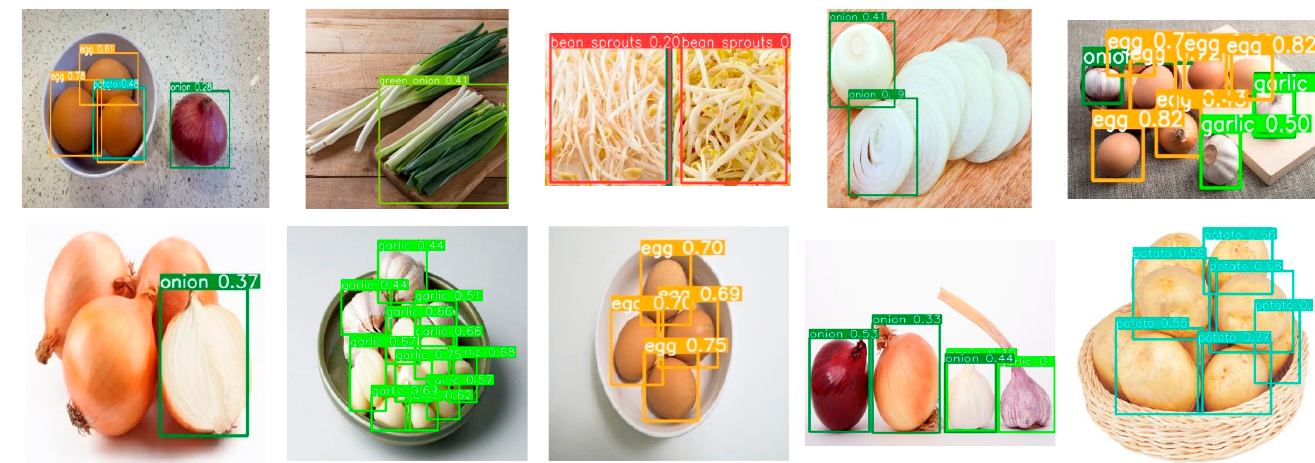
Figure 11. Results of YOLOv5 detection and classification of food